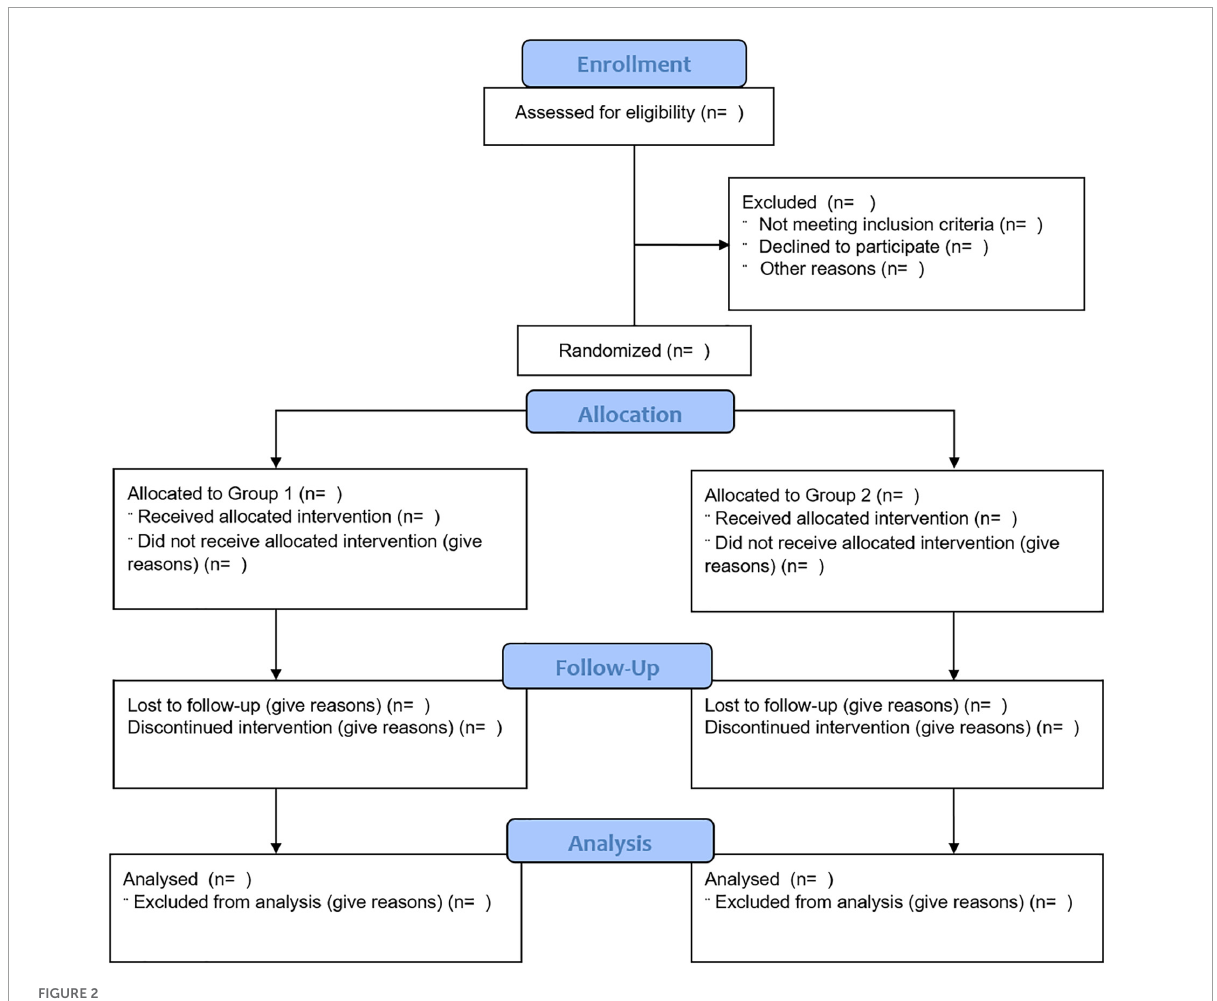
FIGURE2 The study participants flow. The figure shows the flow of the participants through the study.